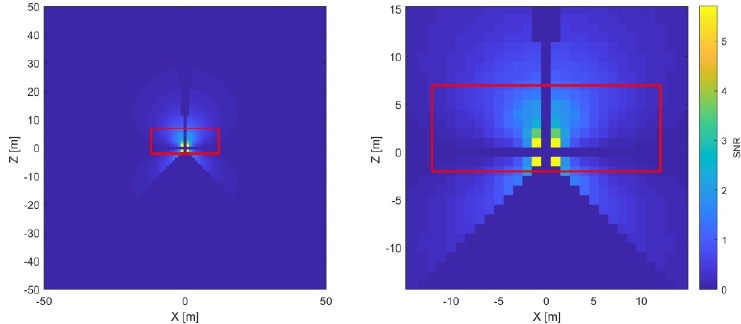
Figure 10. SNR for 𝑥 (cid:2869)(cid:3041)(cid:2878)(cid:2870) in a vertical plane—full field of view (left) and the close-up (right).